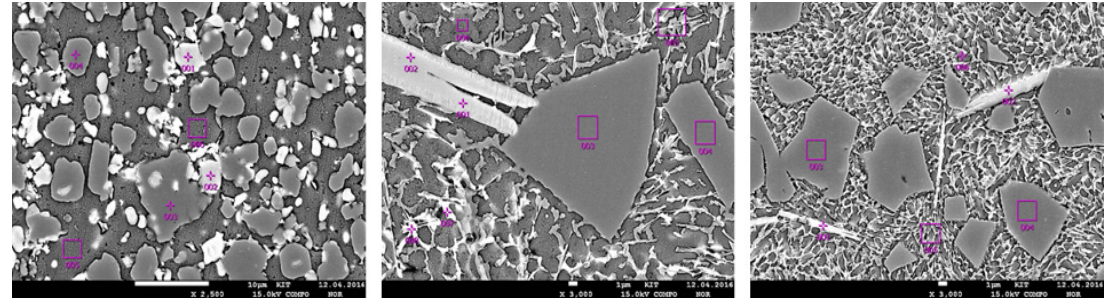
Figure 11. EDX investigation of phases in S263: Left : base material; Middle : welding speed 0.5 m/min; Right : welding speed 10 m/min.